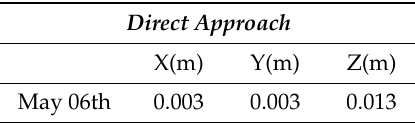
Table 16. Mean standard deviation of five check points from direct approach for the DJI M600 platform from bundle